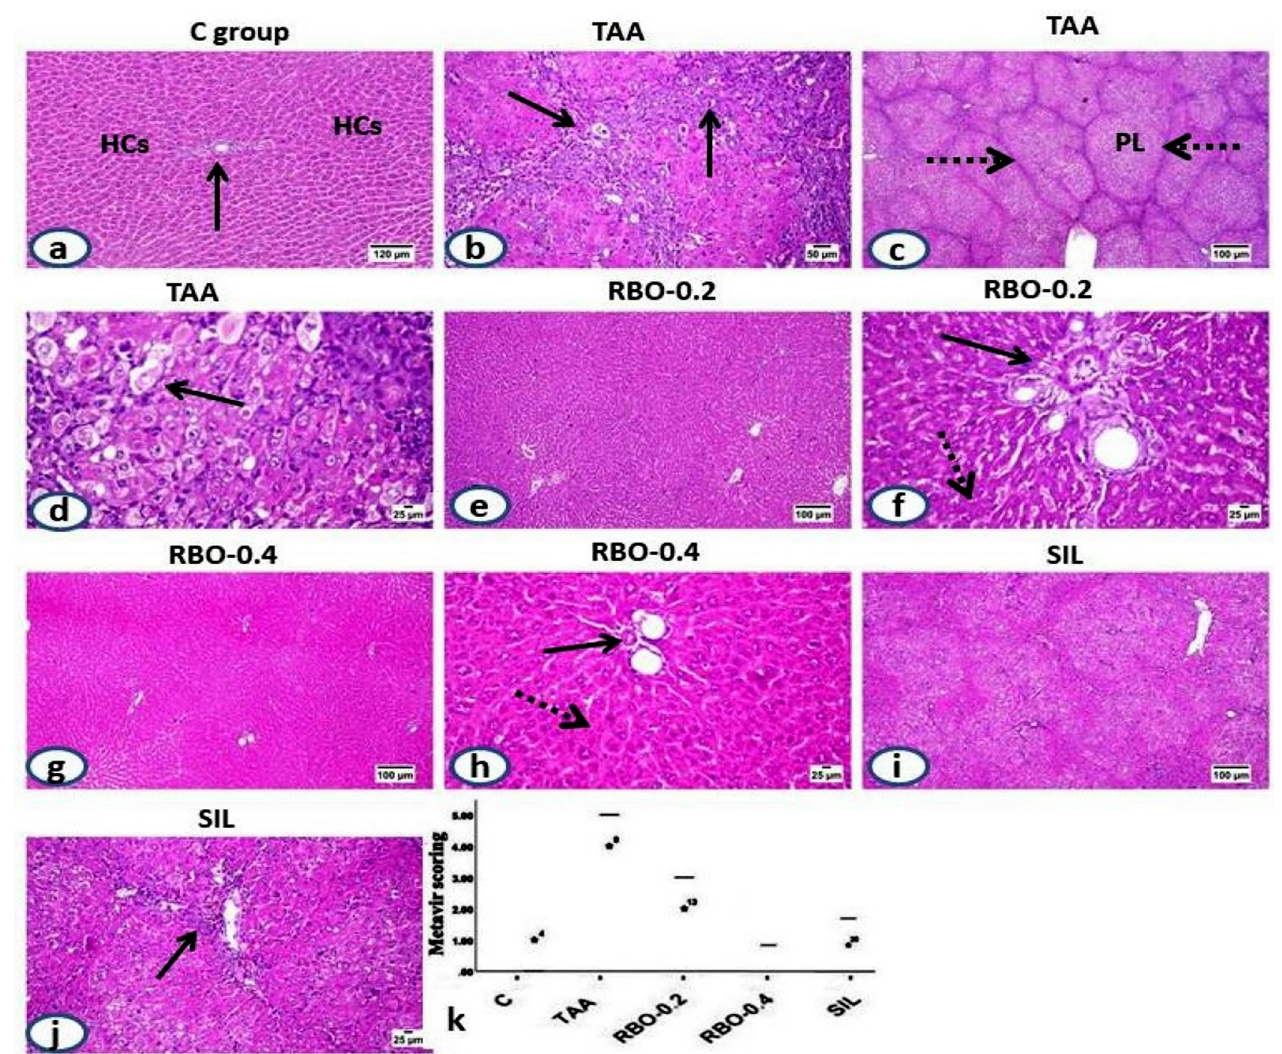
Fig 5. H&E stained liver sections; (a) Liver of control rat shows normal histological structure of central vein (arrow) and hepatic parenchymal cells (HCs). (b- d) liver of TAA-administrated rat showing; (b) thickening of the portal triad (arrow) with fibrous proliferation, inflammatory cells infiltration and proliferated bile duct epithelium, (c) extended fibrous septa (dotted arrow) with marked parenchymal pseudolobulation (PL), (d) vacuolar to ballooning degeneration of the hepatic cells (arrow) and marked apoptosis within pseudo-lobules. (f) (e–h) livers of RBO treated group showing marked retraction of fibrous proliferation without any evidence of pseudolobulation, only at low dose treatment (0.2 mL/rat), mild limited fibroplasia in the portal area (arrow) with scattered necrotic hepatocytes (dotted arrow) and scarce ones at the high dose (0.4 mL/rat) treatment. (I and j) Silymarin treated group showing moderate retraction of parenchymal fibrous with its limitation to the portal areas (arrow). (k) The scoring of the fibrosis extension in TAA and various treated groups using Metavir scoring scale. All data are presented as Mean ± SEM, (n = 6). a P � 0.05 was assumed to denote statistical significance compared to the negative control, b P � 0.05 was assumed to denote statistical significance compared to TAA group. C: control; TAA: Thioacetamide; RBO: Rice bran